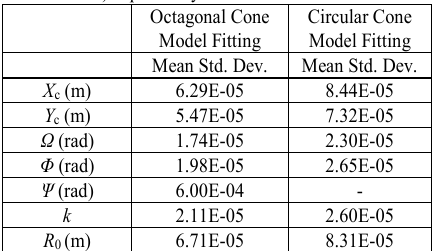
Table 4. Correlation matrix of octagonal cone model fitting with the simulated data Table 7. Comparison of the mean estimated standard deviations of the octagonal and circular cone models fitting with the real data (Poles 1 -